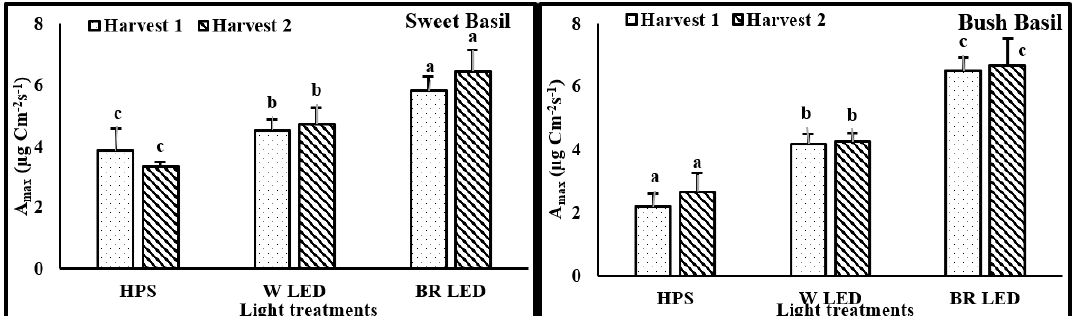
Figure 2. The effect of light treatments and harvest stage on the maximum photosynthetic rate A max of sweet basil (LSD = 0.87 for light treatment) and bush basil (LSD = 0.87 for the light treatment). Different letters denote significant differences ( p < 0.001).